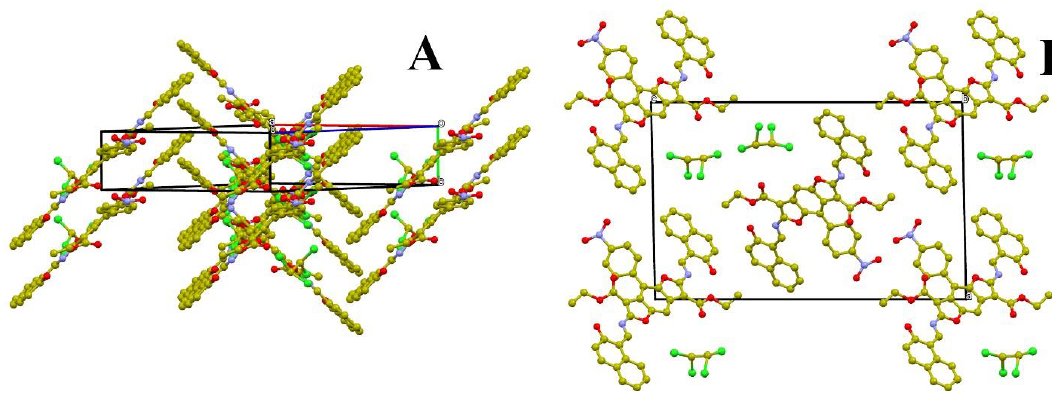
orthogonal view showing NBDF flat structure of the main plane and deviation from planarity of